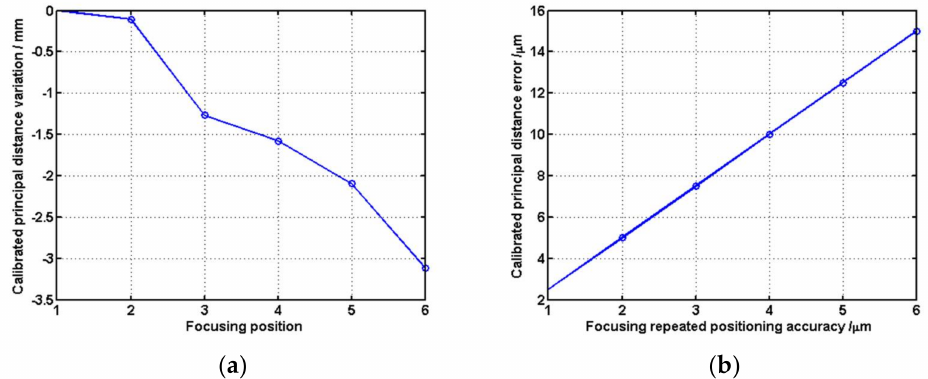
Figure 8. Calibrated principal distance variation (error) curves of the optical system at different conditions: ( a ) different focusing position; ( b ) different repeated focusing-positioning